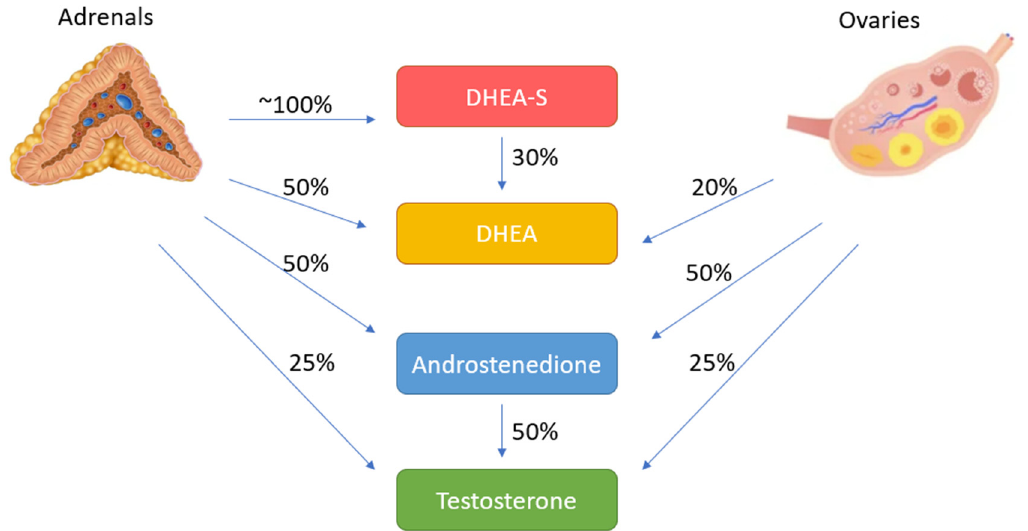
Figure 2. Sources of serum androgens in healthy women.